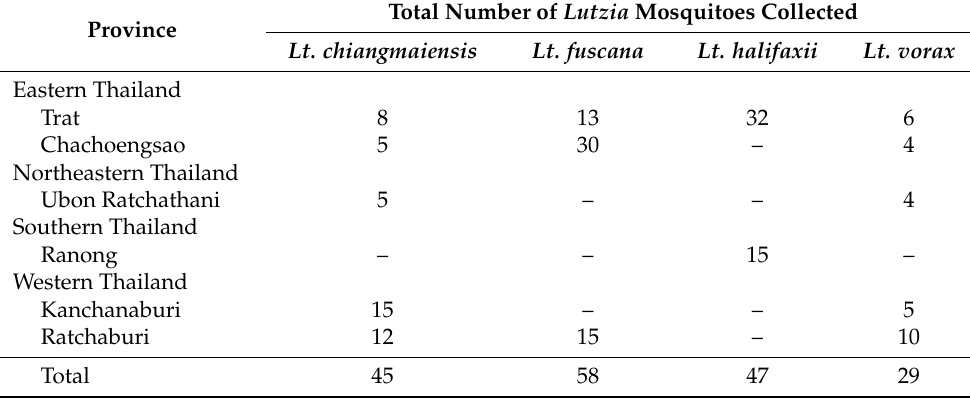
Table 1. Number of Lutzia mosquitoes collected in this